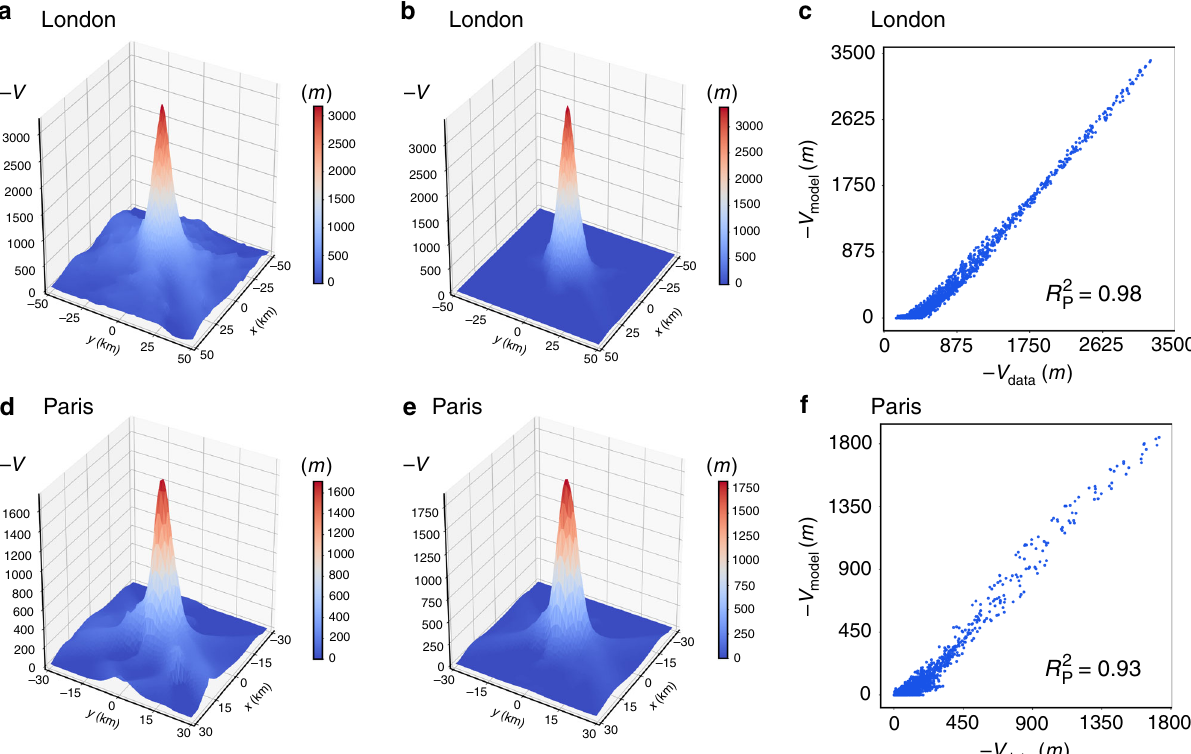
Fig. 6 City potentials. a – c London. d – f Paris. a , d The empirical potential results clearly peaked in the city center, where in overall the density of inhabitants is high. The equilibrium point of the mobility is located at the minimum of the potential. b , e The gravity model predicted potential peaks also at the city center in agreement with the empirical results. c , f Scatter plots comparing gravity model with exponential deterrence function predictions and empirical values of the potential, which show high